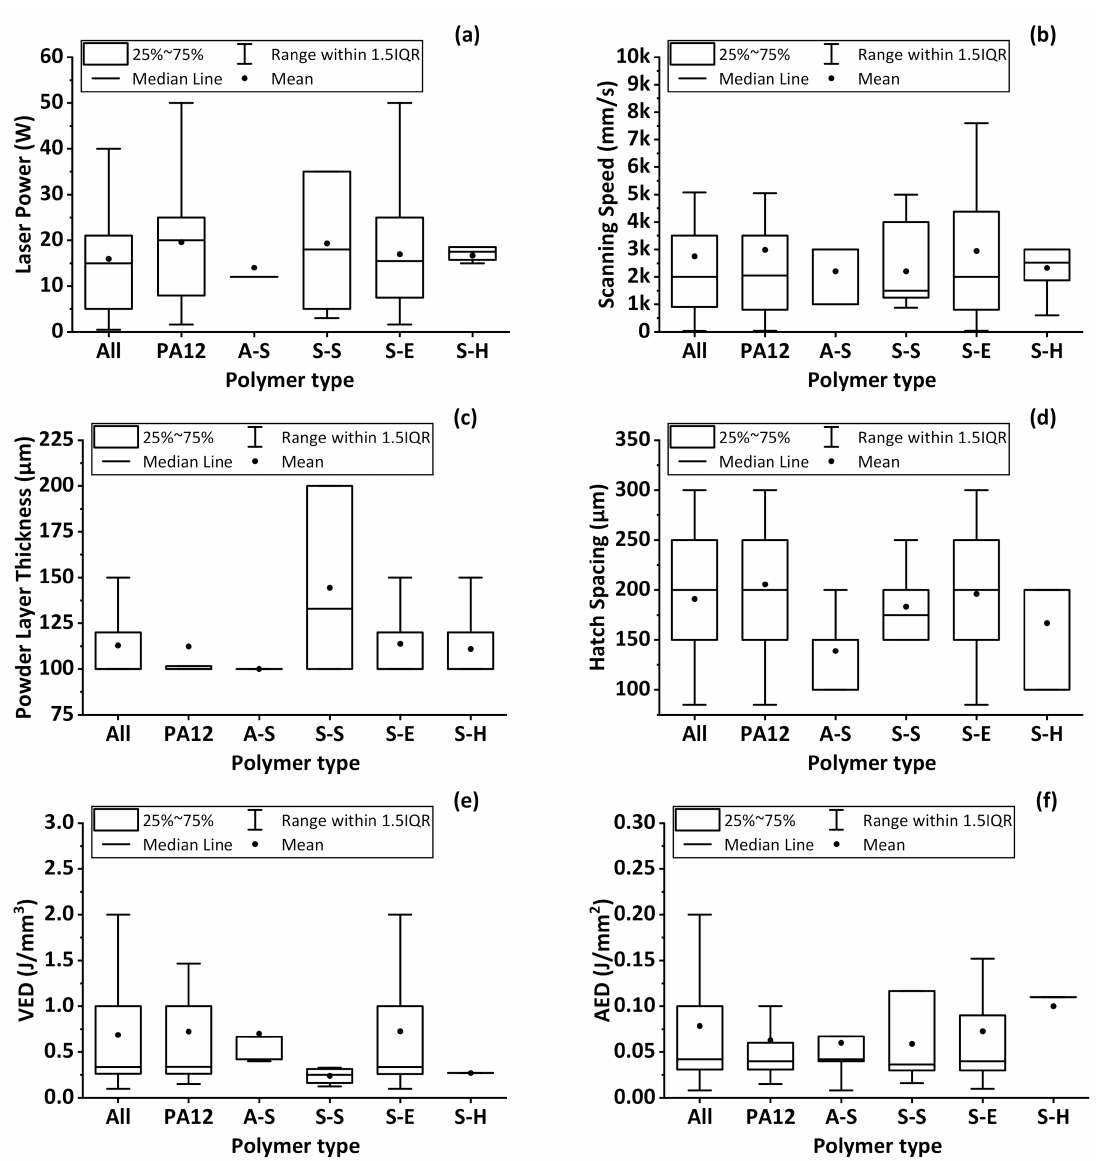
Figure 10. Bibliometrics of the most reported L-PBF process parameters: ( a ) laser power, ( b ) scanning speed, ( c ) powder layer thickness, ( d ) hatch spacing, calculated ( e ) volumetric energy density, and ( f ) areal energy density. The study differentiates between all polymers, PA12, A-S, S-S, S-E, and S-H powder feedstocks [11–111]. Outlier points are not